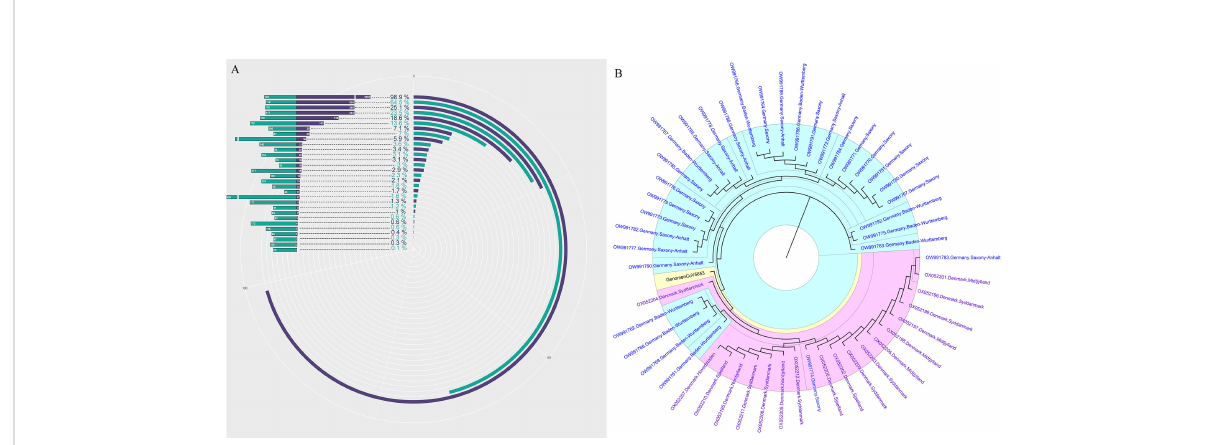
FIGURE 2 The genome of SARS-CoV-2 analysis based on mNGS. (A) The genome coverage of SARS-CoV-2 increases with the increasing reads of SARS- CoV-2. (B) The evolutionary tree analysis between our sample-GenomenCoV5653 and the 50 optimal genome alignment from